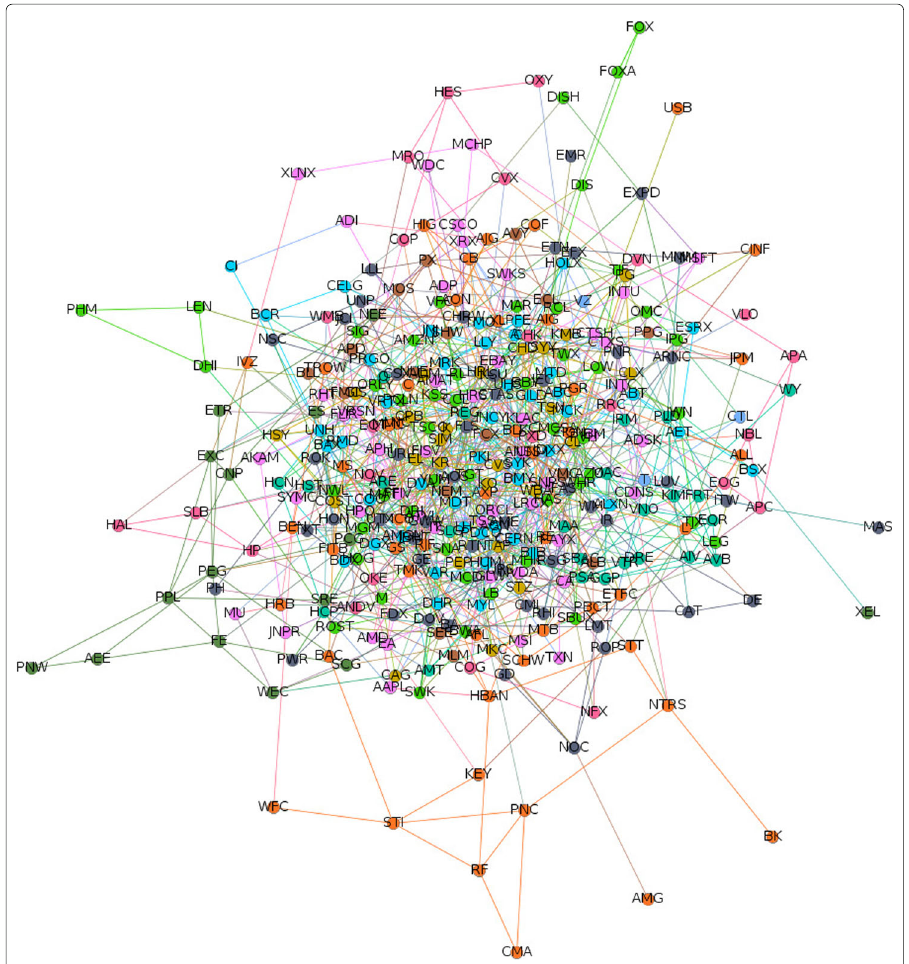
Fig. 2 Example partial correlation network inferred from the first window. Only the 1000 edges with the largest absolute weights are shown. Nodes are coloured according to sector membership. There seems to be less sector clustering in the partial correlation networks and less of a community structure